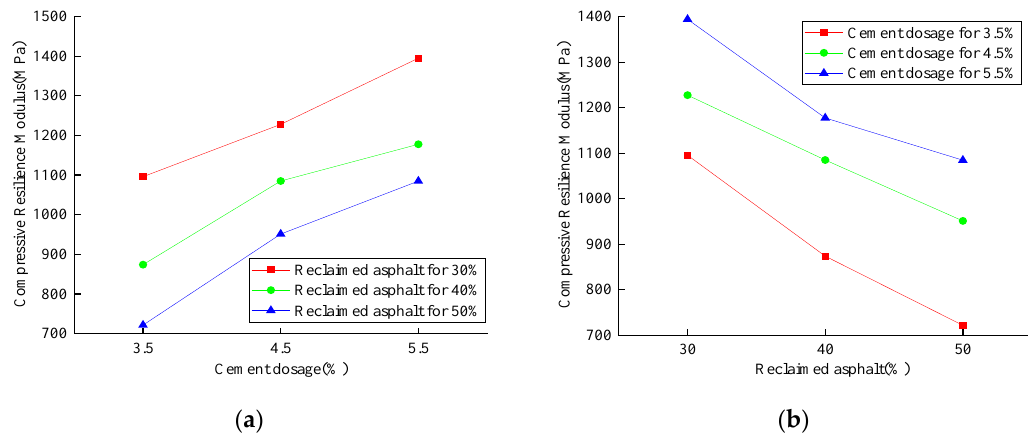
Materials 2021 , 14 , x FOR PEER REVIEW